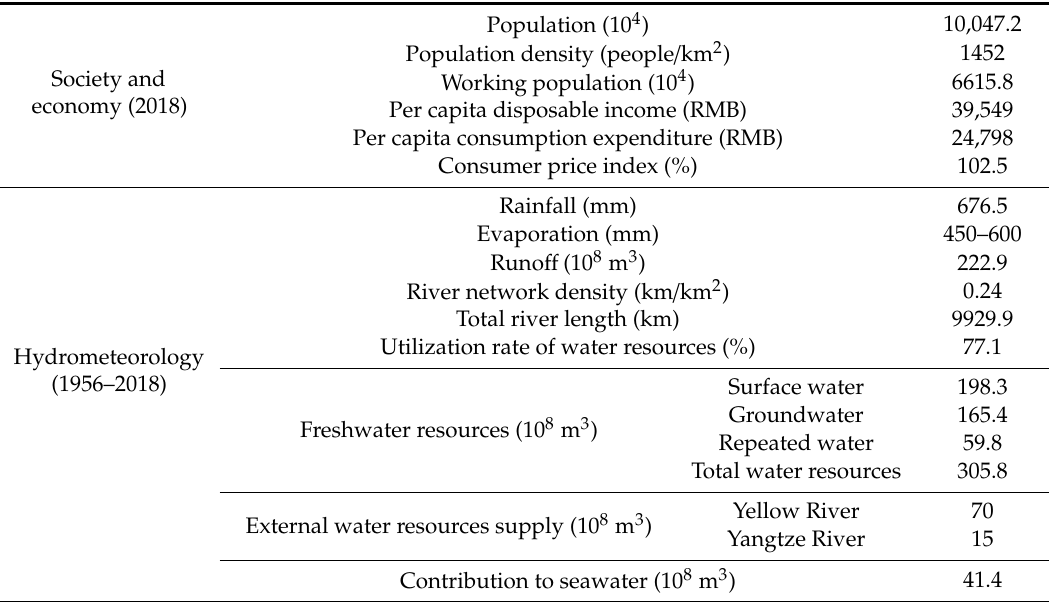
Table 1. Social economy and hydrometeorology in